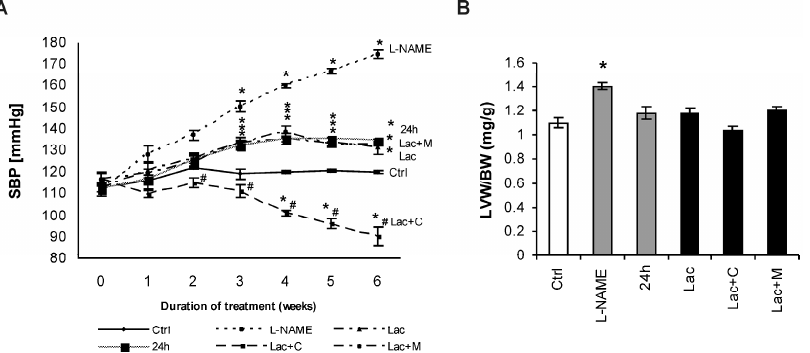
Figure 1. Systolic blood pressure (SBP) ( A ) and relative left ventricular weight (LVW/BW) ( B ) in the control group (Ctrl), L-NAME (L-NAME)-, continuous 24 h/day light (24 h)-, lactacystin (Lac)-induced hypertension, and in lactacystin-hypertension influenced by captopril (Lac+C) or melatonin (Lac+M). * p < 0.05 vs. Ctrl, # p < 0.05 vs. Lac.